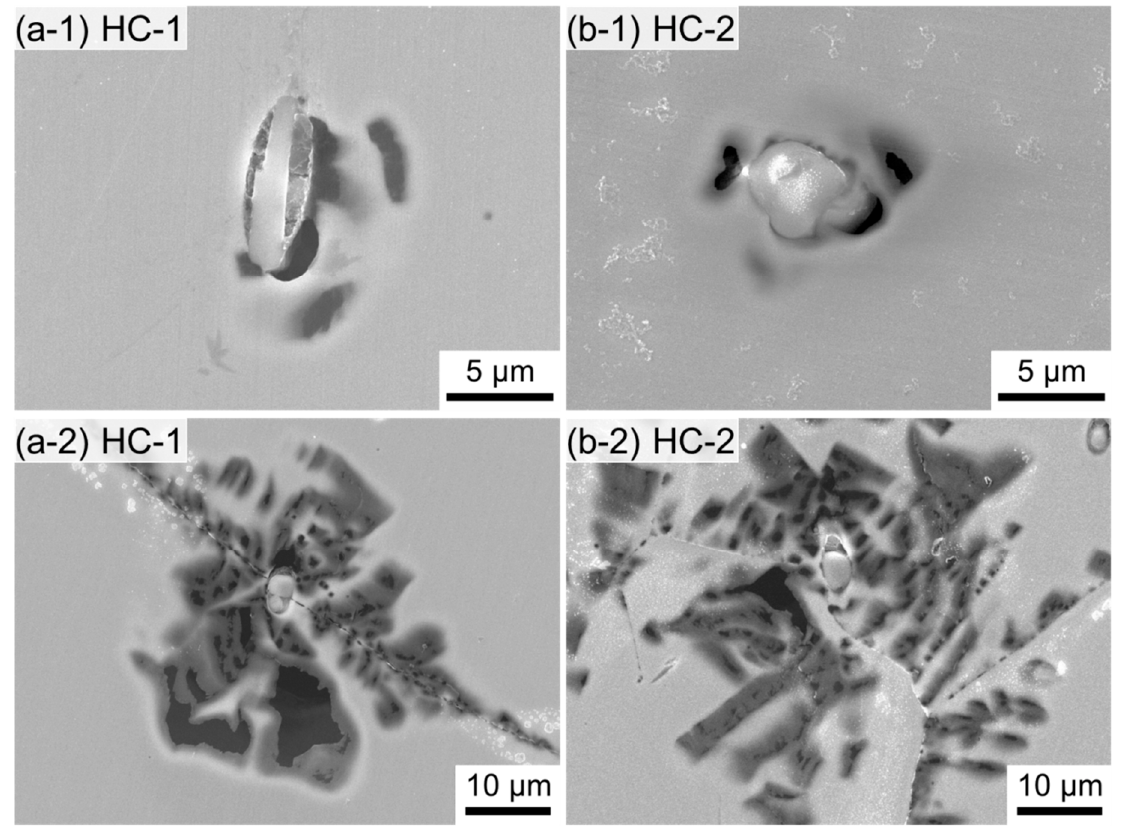
Figure 10. SEM images for pits formed in the ( a ) HC-1 and ( b ) HC-2 samples after potentiodynamic polarization in a 3.5 wt% NaCl solution. ( a-1 , b-1 ) Initiation and ( a-2 , b-2 ) propagation of pitting corrosion.